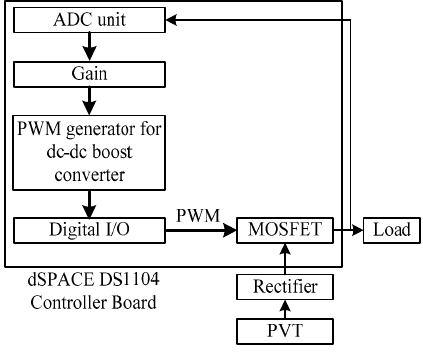
Figure 3. Block diagram of the dSPACE DS1104 controller converter.